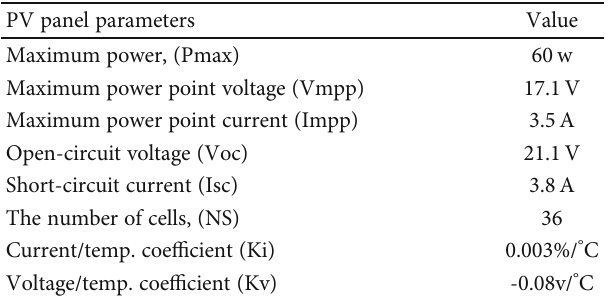
Table 1: Electrical characteristics of the MSX-60